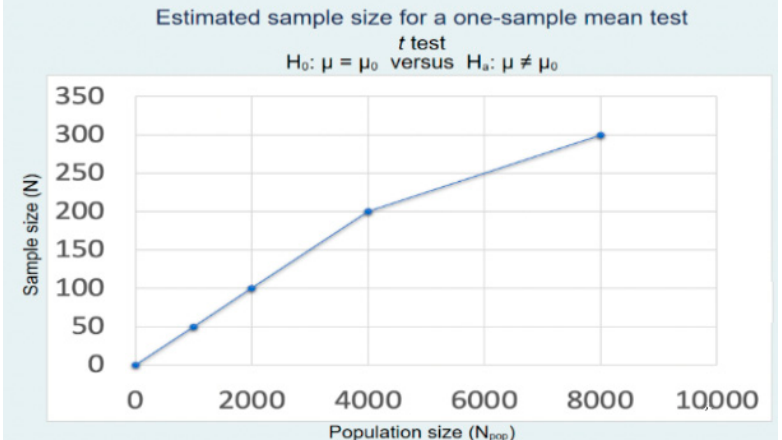
Figure 1. Sample size estimation for dentists. Parameters: α = 0.05, 1 – β = 0.8, δ = 0.29, µ 0 = 0.01, µ a = 0.3, σ =